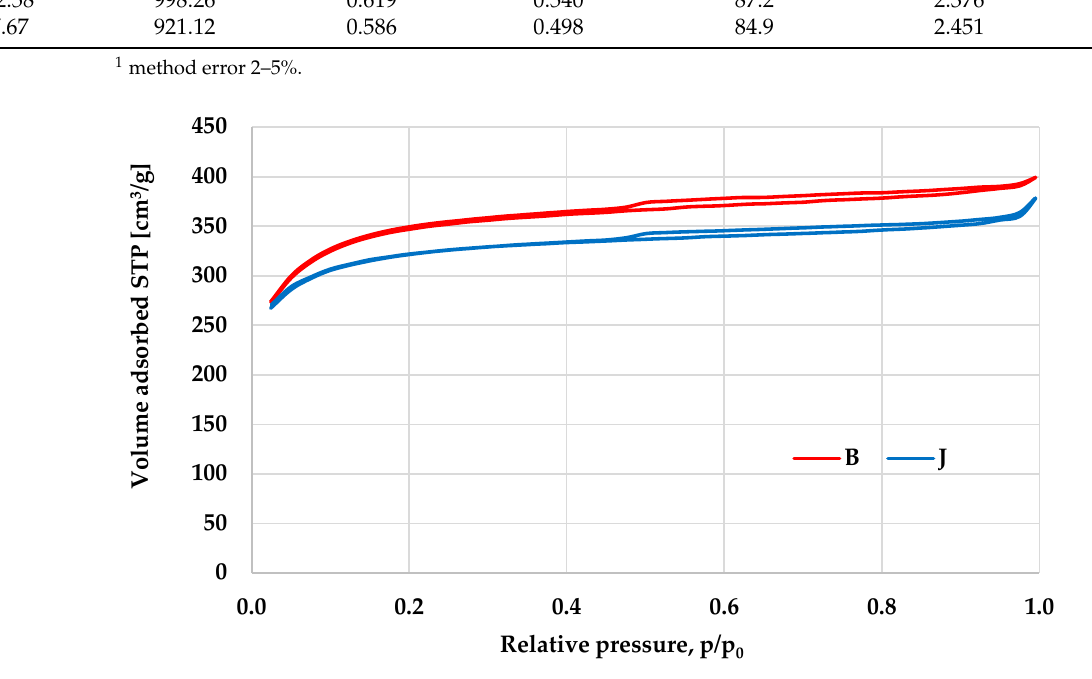
Figure 3. N 2 adsorption-desorption isotherms of carbonaceous materials recovered from exhausted filter cartridges.